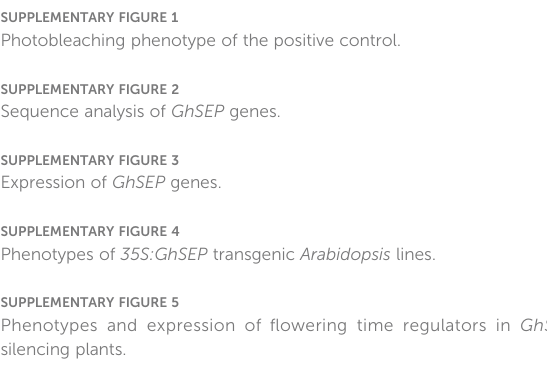
SUPPLEMENTARY FIGURE 1 Photobleaching phenotype of the positive control. SUPPLEMENTARY FIGURE 2 Sequence analysis of GhSEP genes. SUPPLEMENTARY FIGURE 3 Expression of GhSEP genes. SUPPLEMENTARY FIGURE 4 Phenotypes of 35S:GhSEP transgenic Arabidopsis lines. SUPPLEMENTARY FIGURE 5 Phenotypes and expression of fl owering time regulators in GhSEP silencing plants. SUPPLEMENTARY FIGURE 6 Expression of fl owering time regulators in 35S:GhSEP s. SUPPLEMENTARY FIGURE 7 Detection of fusion proteins by Western blot. SUPPLEMENTARY TABLE 1 Primer list. SUPPLEMENTARY TABLE 2 List of the proteins used in the phylogenetic tree. SUPPLEMENTARY TABLE 3 List of SEP -like genes in G. hirsutum . SUPPLEMENTARY TABLE 4 Sequence similarity of SEP -like genes in G. hirsutum